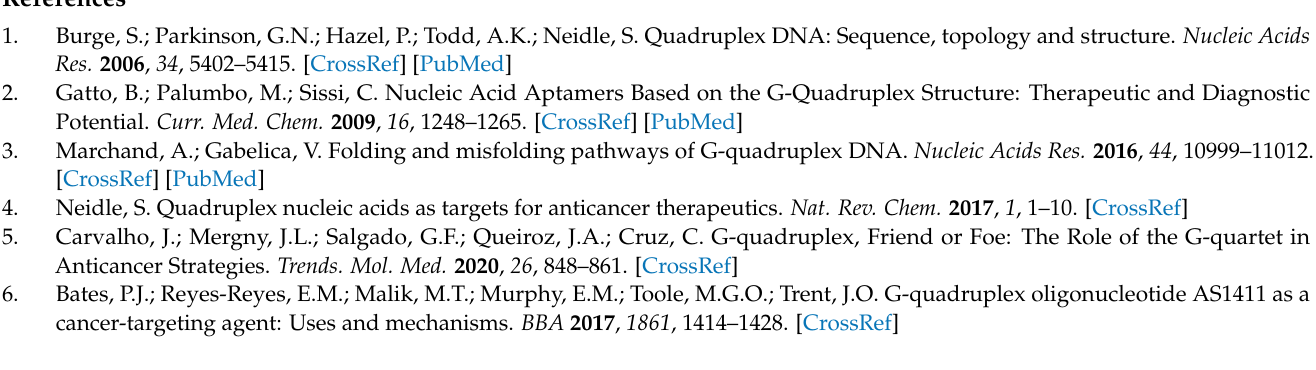
dependence vs. sample concentration of ON2, Figure S3: Tm dependence vs. sample concentration of ON3, Figure S4: Tm dependence vs. sample concentration of ON4, Figure S5: Tm dependence vs. sample concentration of ON5, Figure S6: CD spectra at 37 ◦ C of the 5 (cid:48) -FAM-labeled oligonucleotides ON1–ON5, Figure S7: Normalized thermal difference spectra of 5 (cid:48) -FAM-labeled oligonucleotides ON1–ON5, Figure S8: Antiproliferative activity of the FAM-labeled oligonucleotides ON1 to ON5 studied at 10 µ M. HeLa cells cultured without oligonucleotides constituted the control, Figure S9: Representative heating and annealing curve of DNA G-quadruplex analyzed with 0.2 ◦ C/min ramp rate, Figure S10: The comparison of general tendency of changes in thermodynamic stability and antiproliferative properties of labeled and unlabeled